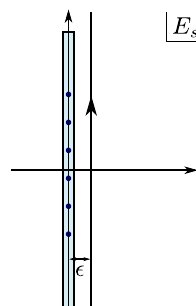
Figure 3. Poles of the four-point function integrand and integration contour for the c Liouville theory. The poles in the E s -plane are located on the imaginary axis (shaded area, only few poles are displayed) and depend only on (cid:12) , not on the external momenta (cid:11) 1 ; (cid:11) 2 ; (cid:11) 3 and (cid:11) 4 . The i (cid:15) prescription shifts the contour away from the